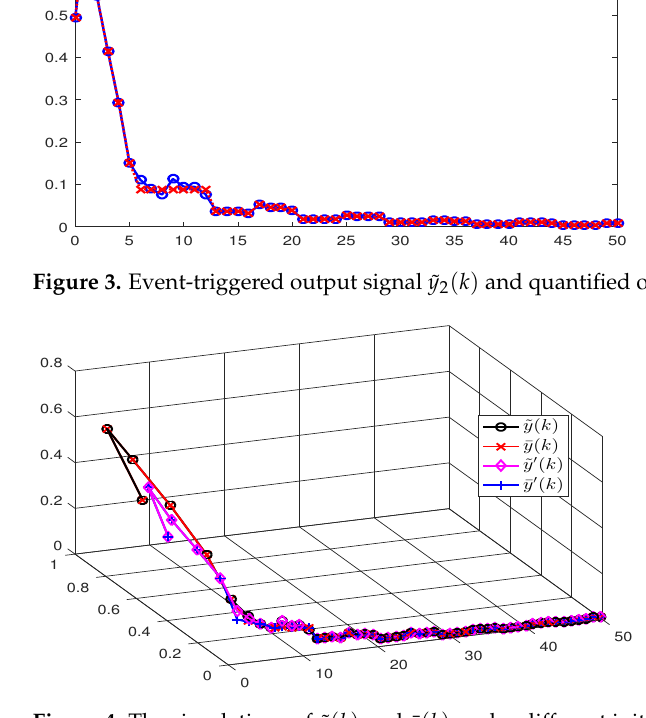
Figure 4. The simulations of ˜ y ( k ) and ¯ y ( k ) under different initial